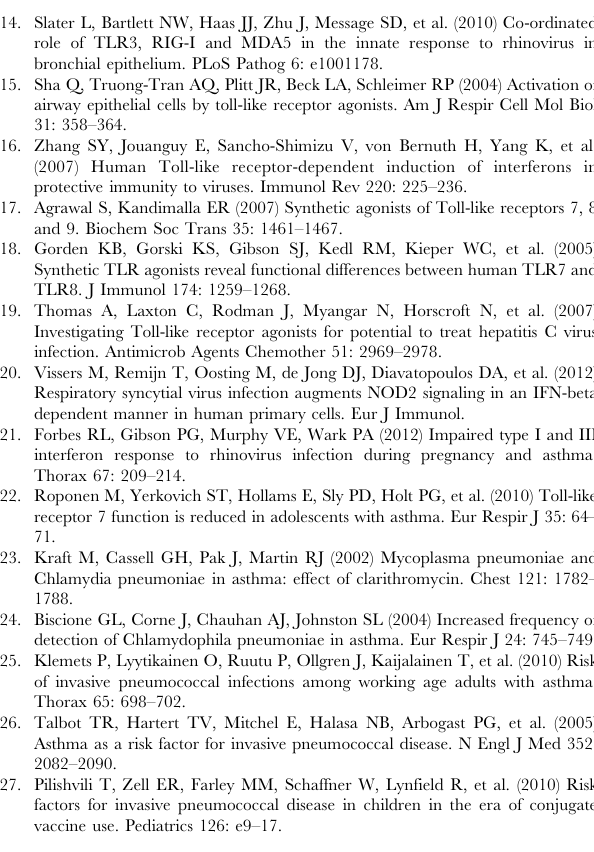
Table S1 TLR agonists and doses used for HBECs and PBMCs. Table S2 Doses of TLR agonists used in preliminary experie- ments. Table S3 Primer and probe sequences used. Table S4 Clinical characteristics of participants from whom HBEC samples were successfully